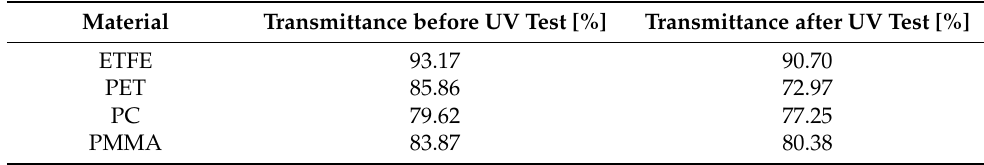
Figure 3. Transmittance patterns of light weight front materials before and after the UV test. Table 1. Average transmittances of lightweight materials before and after the UV test in the wave- length spectrum of 300–1200 nm.